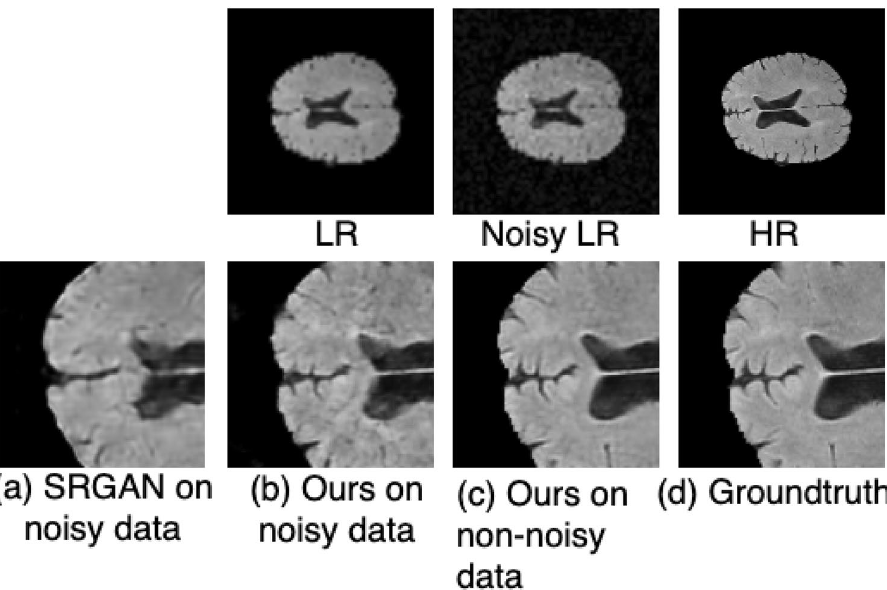
Figure 15. Small region results for noisy data. Top Row shows LR image, the noisy LR image and ground truth HR image. Bottom row contains the extracted small region results. ( a ) Shows the SRGAN results. ( b ) Shows the results of the proposed method on noisy image. ( c ) Shows the results of the proposed method on original image (non noisy) image, and ( d ) shows the corresponding ground truth HR image. Images re-scaled for better display purpose.